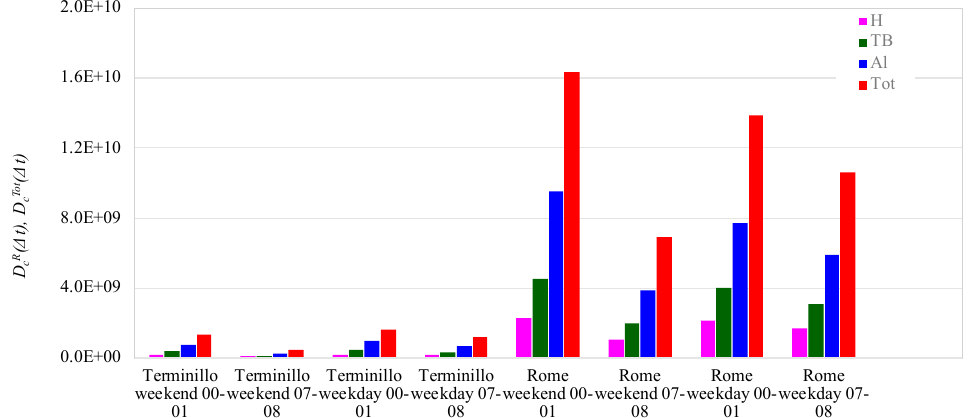
Figure 3. Cumulative regional number doses ( D CR ( ∆ t) ) and cumulative total number dose ( D CTot ( ∆ t) )